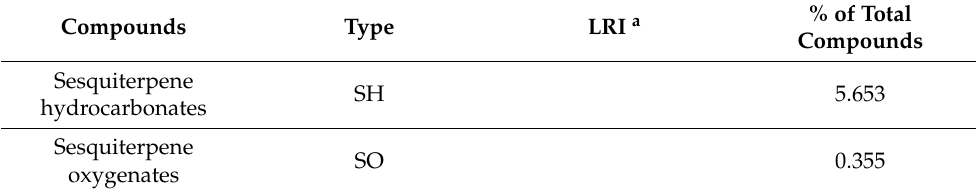
Table 1. Cont. Compounds